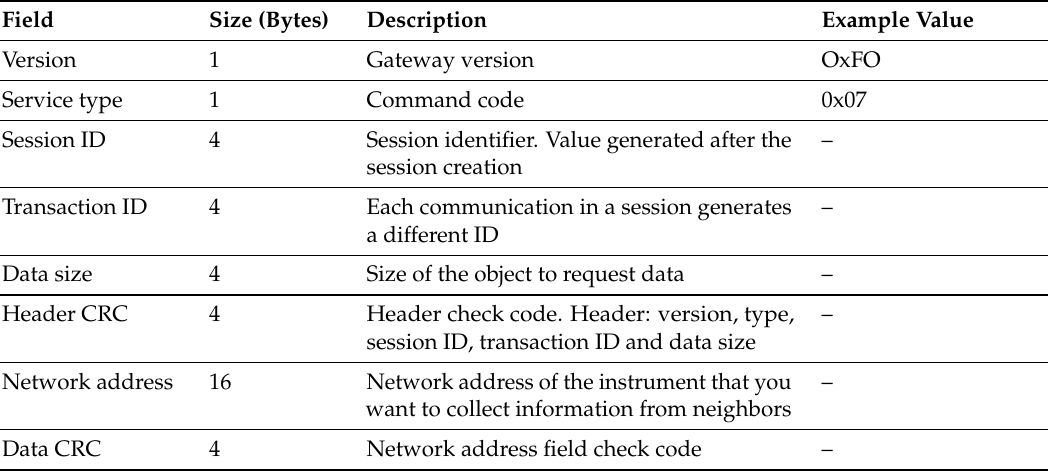
Table 5. GSAP command fields: Neighbor_Health request